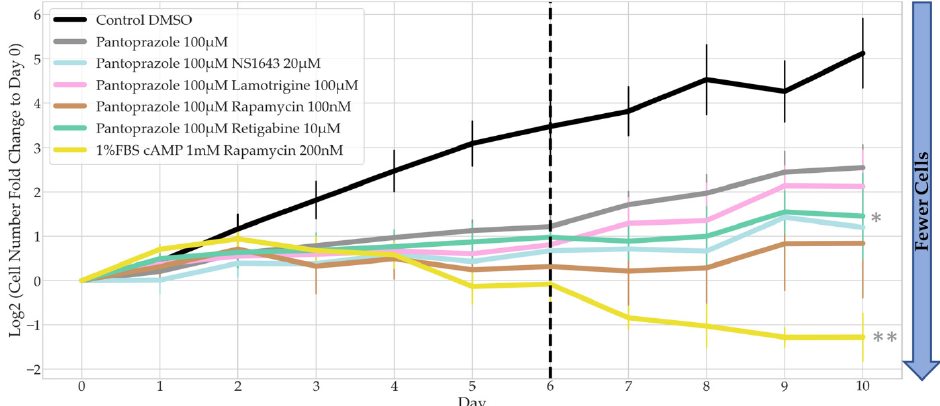
Figure 3. Recovery Test of Bioelectric Treatments in Combination with Pantoprazole in NG108-15 FUCCI Cells. The log2 of the fold change in cell counts to Day 0 were recorded for 10 days. Dotted line marks the day on which drug treatment was removed and replaced with control media ( n > 3 biological replicates). Combination drug treatment slopes from Day 6 to Day 10 were compared to pantoprazole alone, significance is shown with grey stars next to the corresponding line **: p < 0.01, *: p < 0.05 (one-way ANOVA with Dunnett post hoc analysis n > 3 biological replicates).